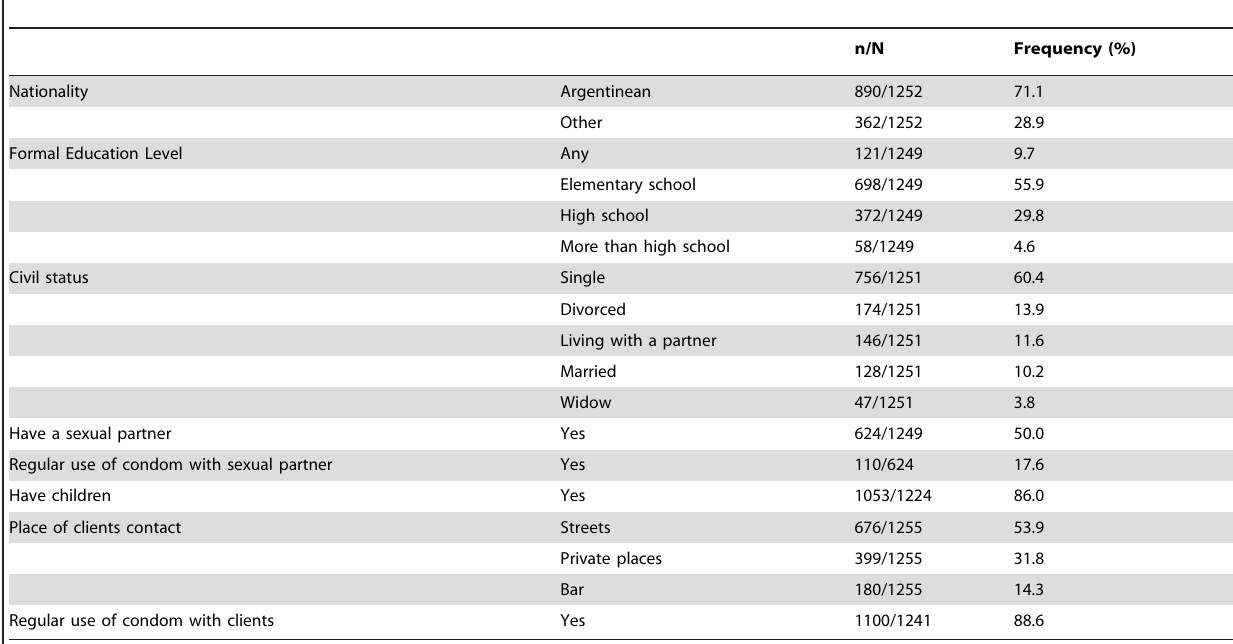
Table 1. Socio-demographics characteristics of 1255 FSWs recruited in nine cities of Argentina between 2006 and